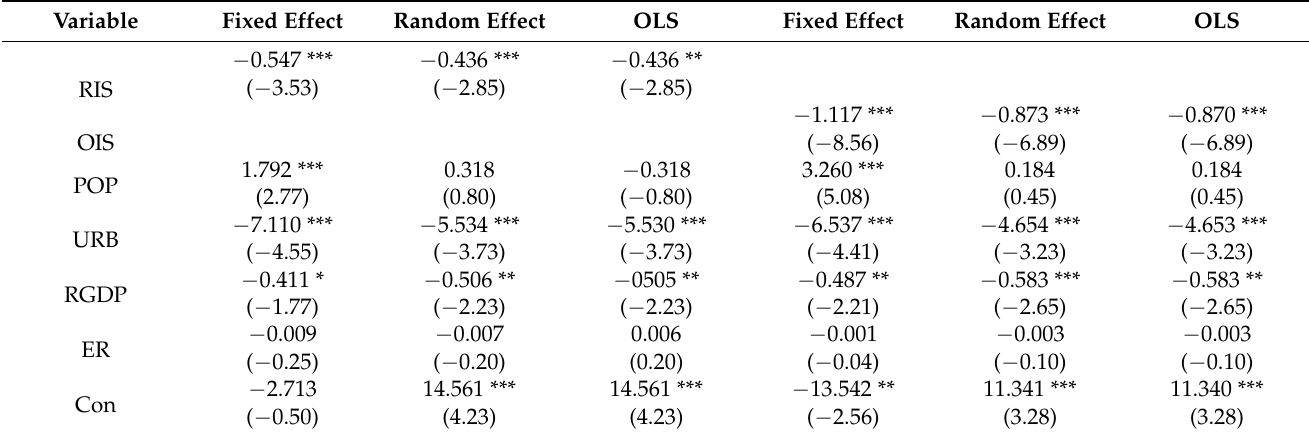
Table 3. The overall regression